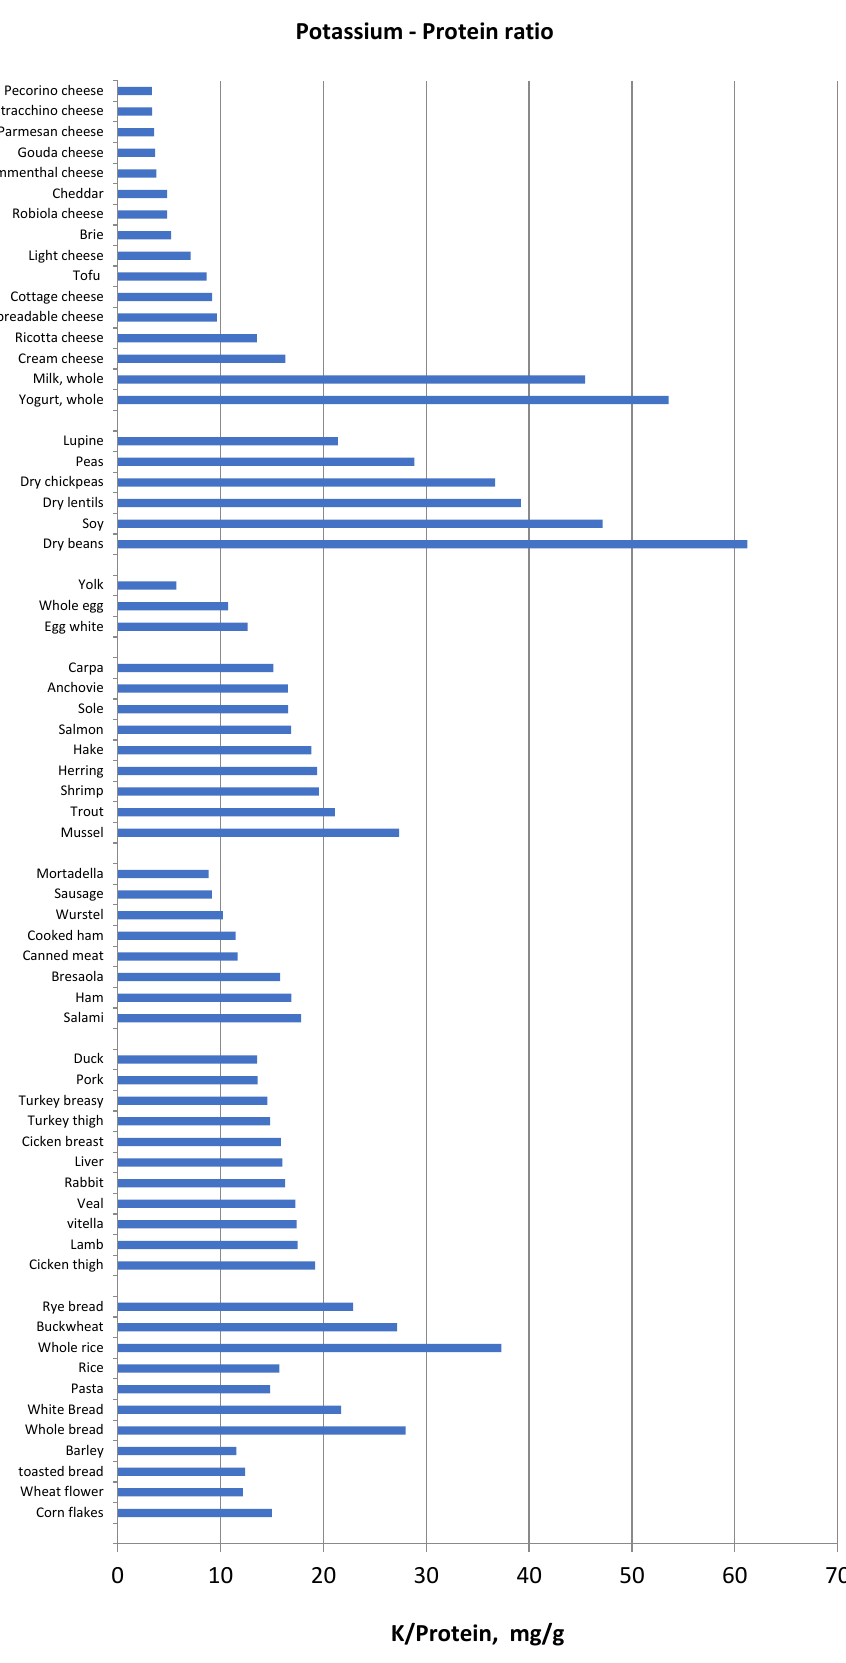
Figure 1. Potassium to fibre ratio (mg/g) in several food categories.